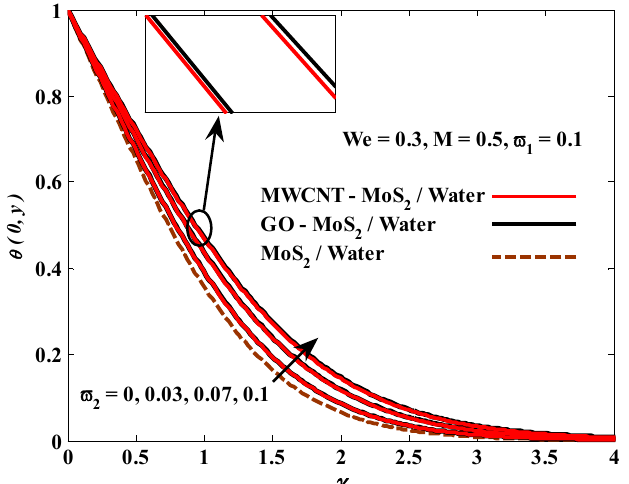
Figure 11. The behavior of hybrid nanofluid’s temperature under the effect of ultrafine particle volume fraction.